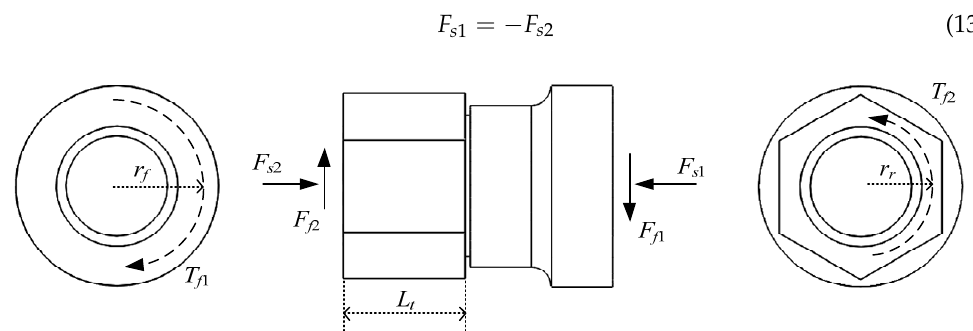
Figure 10. Force analysis of hi-lok nut at hex aligning time (before going into the socket). Circumferentially, the two friction forces need to be looked at. Let the friction coeffi- cient between the end sides of the two fingers and the front surface of the nut be f 1 , and the friction coefficient between the front surface of the socket of the nut runner and the rear surface of the nut be f 2 , then the respective friction force F f1 and F f2 are expressed